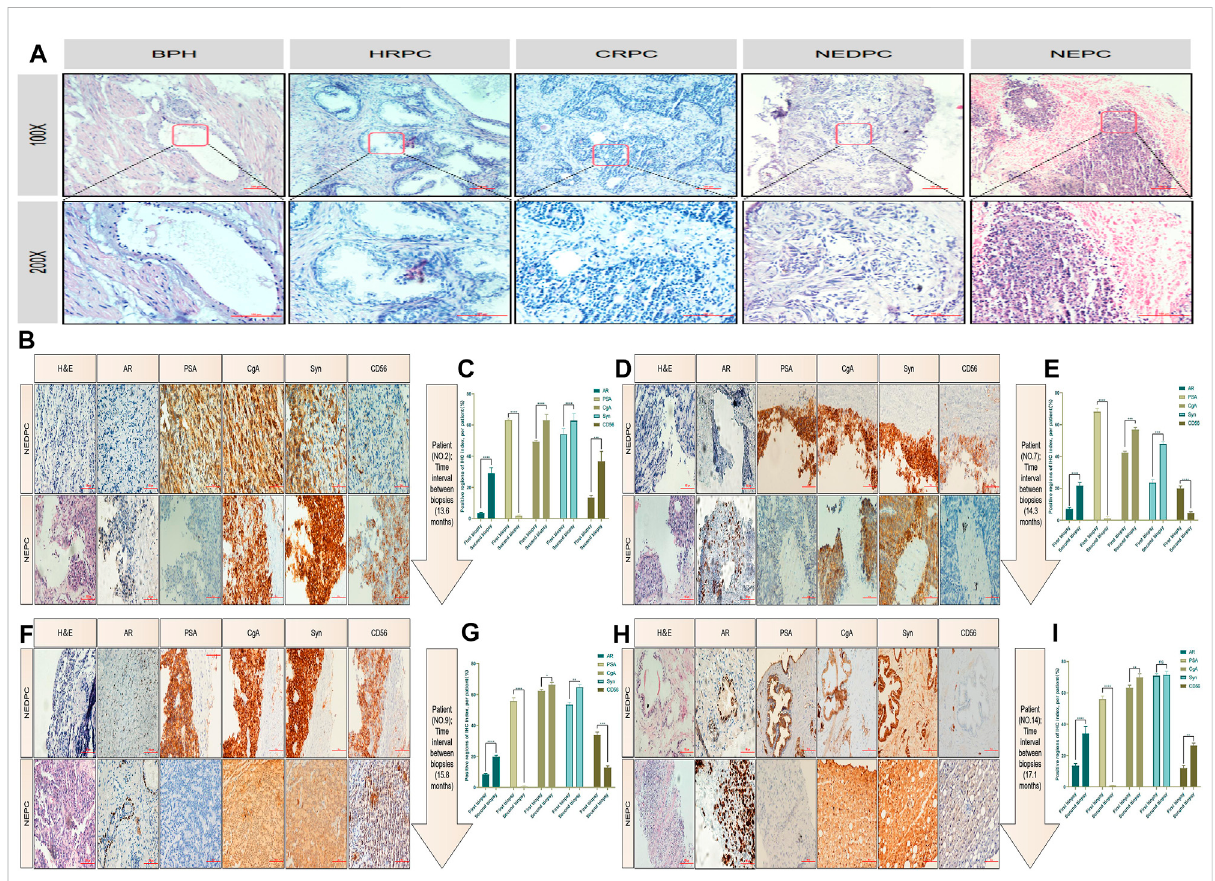
FIGURE 3 HEstaining andimmunohistochemical stainingfor patients. (A) Malignant degree ofprostate tissueofHE staining, includingBPH, HRPC,CRPC, NEDPC, NEPC. (B) HE staining and Immunohistochemical staining of the patient ’ s (Numble 2) two prostate biopsy tissues, including AR, PSA, CgA, SynandCD56indicators. (C) Comparison ofquantitative resultsoffourindicatorsofprostatetissuesimmunohistochemistrystainingatanintervalof 13.6 months(PatientNo.2). (D) HEstainingandImmunohistochemicalstainingofthepatient ’ s(Numble7)twoprostatebiopsytissues,including AR,PSA,CgA,SynandCD56indicators. (E) Comparisonofquantitativeresultsoffourindicatorsofprostatetissuesimmunohistochemistrystainingat an interval of 14.3 months (Patient No. 7). (F) HE staining and Immunohistochemical staining of the patient ’ s (Numble 9) two prostate biopsy tissues, includingAR,PSA,CgA,SynandCD56 indicators. (G) Comparisonofquantitativeresults offour indicatorsofprostate tissuesimmunohistochemistry staining at an interval of 15.8 months (Patient No. 9). (H) HE staining and Immunohistochemical staining of the patient ’ s (Numble 14) two biopsy tissues, including AR, PSA, CgA, Syn and CD56 indicators. The fi rst biopsy site was the prostate and the second was the liver. (I) Comparison